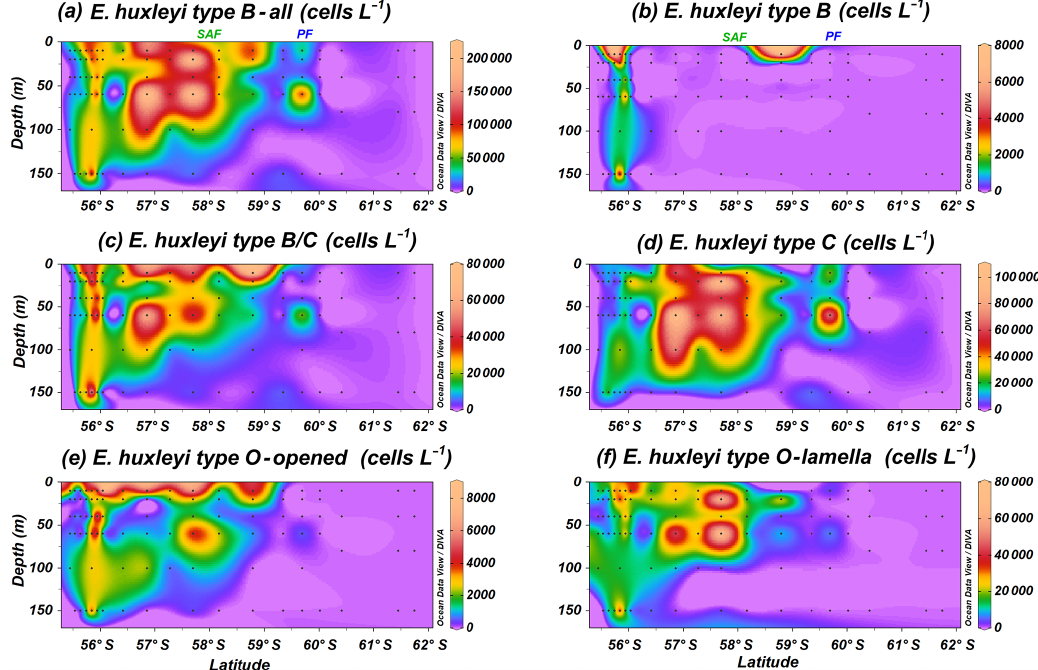
Figure 5. Location of the PS97 CTD stations studied showing the number of coccospheres per litre of (a) Emiliania huxleyi type B group, (b) E. huxleyi type B, (c) E. huxleyi type B/C, (d) E. huxleyi type C, (e) E. huxleyi type O (with opened central area), and (f) E. huxleyi type O (with lamella). The Subantarctic Front (SAF) and the Polar Front (PF), according to Orsi et al. (1995), are indicated.